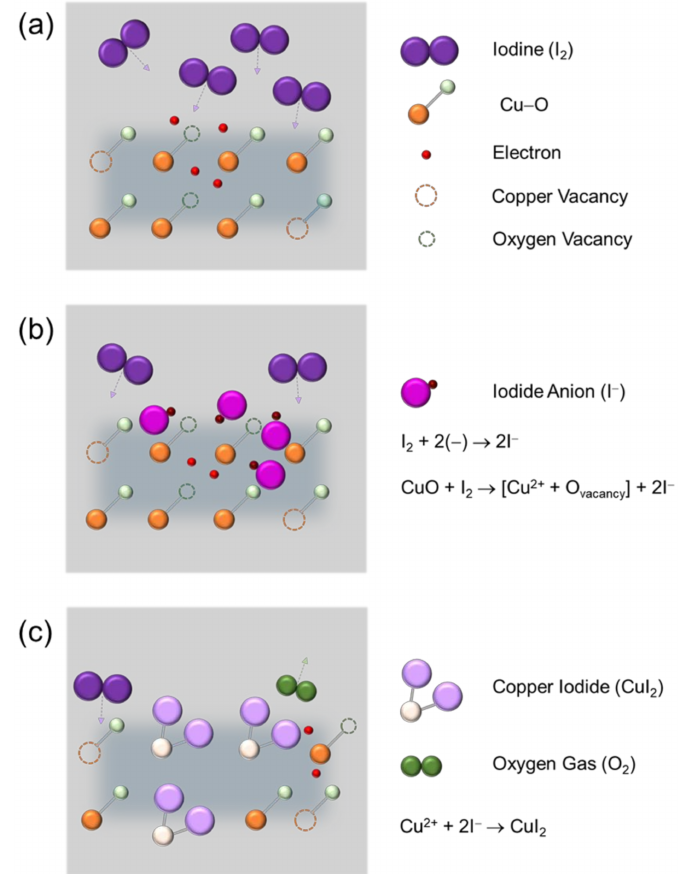
Figure 7. Possible reactions caused by iodine in the CuO film. ( a ) CuO film before iodine penetration, ( b ) formation of iodide anions after iodine penetration, and ( c ) formation of copper